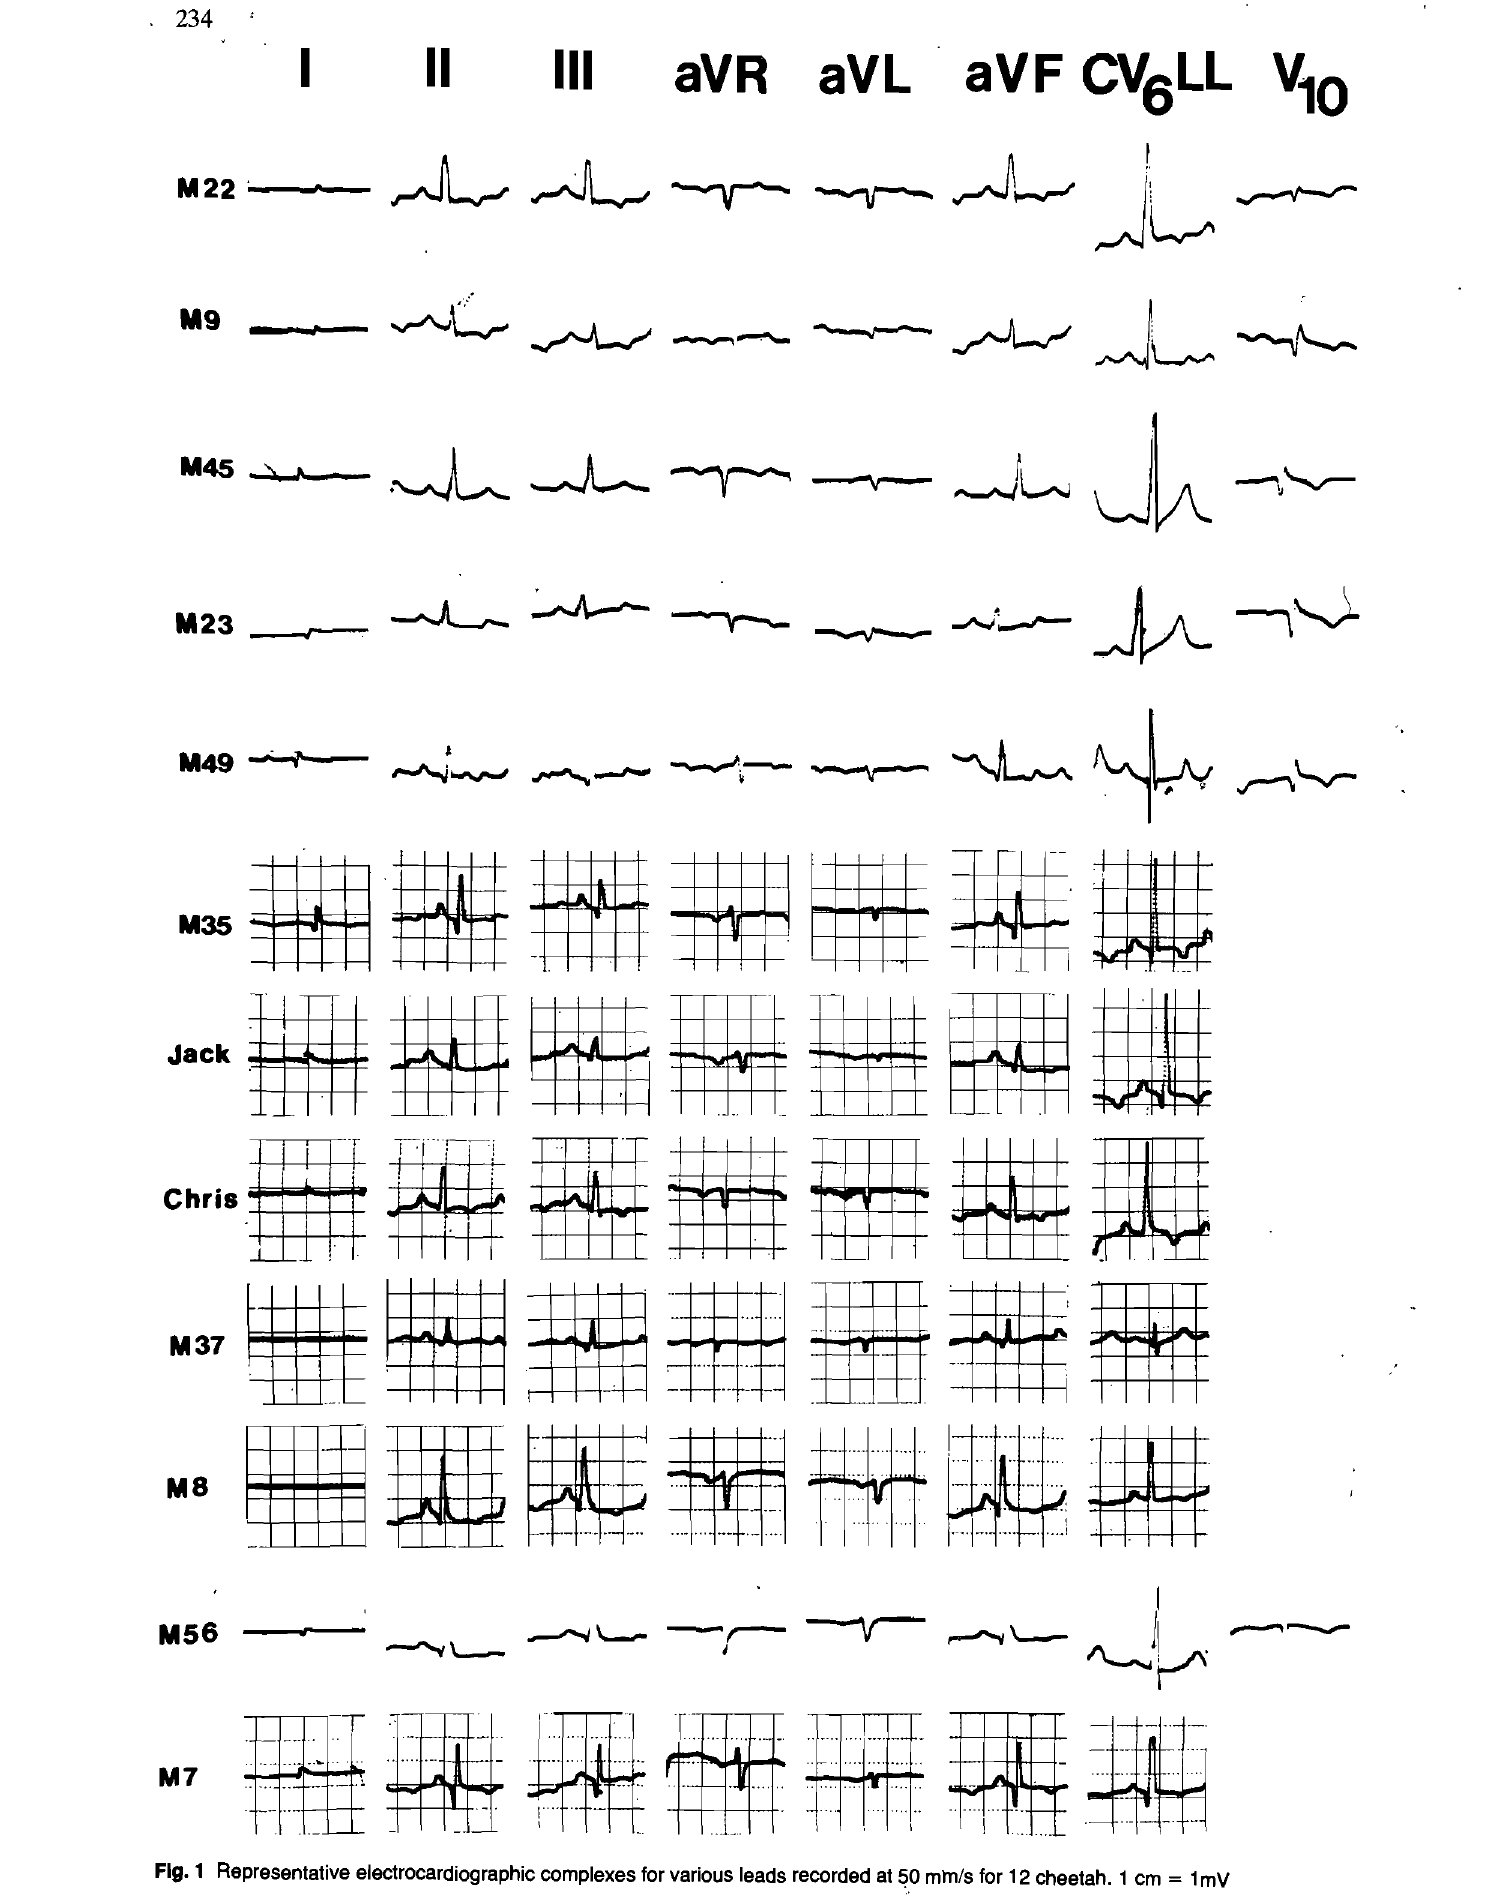
Fig. 1 Representative electrocardiographic complexes for various leads recorded at 50 mtn/s for 12 Cheetah. 1 cm = 1 mV TYDSKRIF VAN DIE SUID-AFRIKAANSE VETERINERE VERENIGING - SEPTEMBER